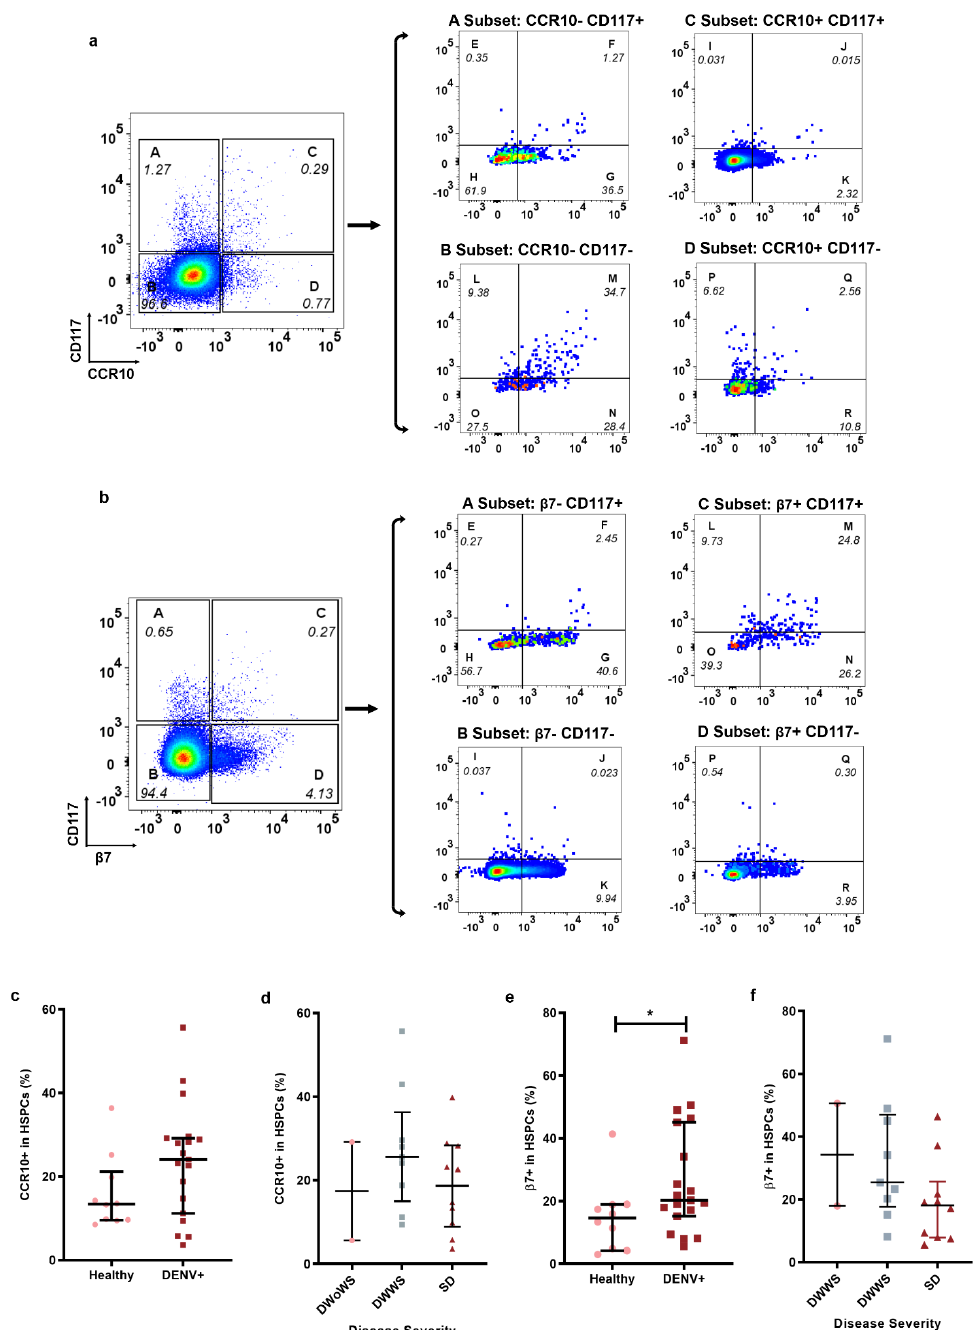
Figure 2. Percentage of skin- or gut-homing HSPCs in dengue patients. The percentage of skin-homing HSPCs and gut-homing HSPCs was analyzed in WBCs from healthy individuals (Healthy, n = 10, • ) and dengue patients (DENV+, n = 19, (cid:4) ) using flow cytometry. ( a ) Gating strategy for skin-homing HSPCs. ( c , d ) The percentage of skin-homing HSPCs (CCR10+ in HSPCs). ( b ) Gating strategy for gut-homing HSPCs. ( e , f ) The percentage of gut-homing HSPCs ( β 7+ in HSPCs). c (IQR). p < 0.05 *.